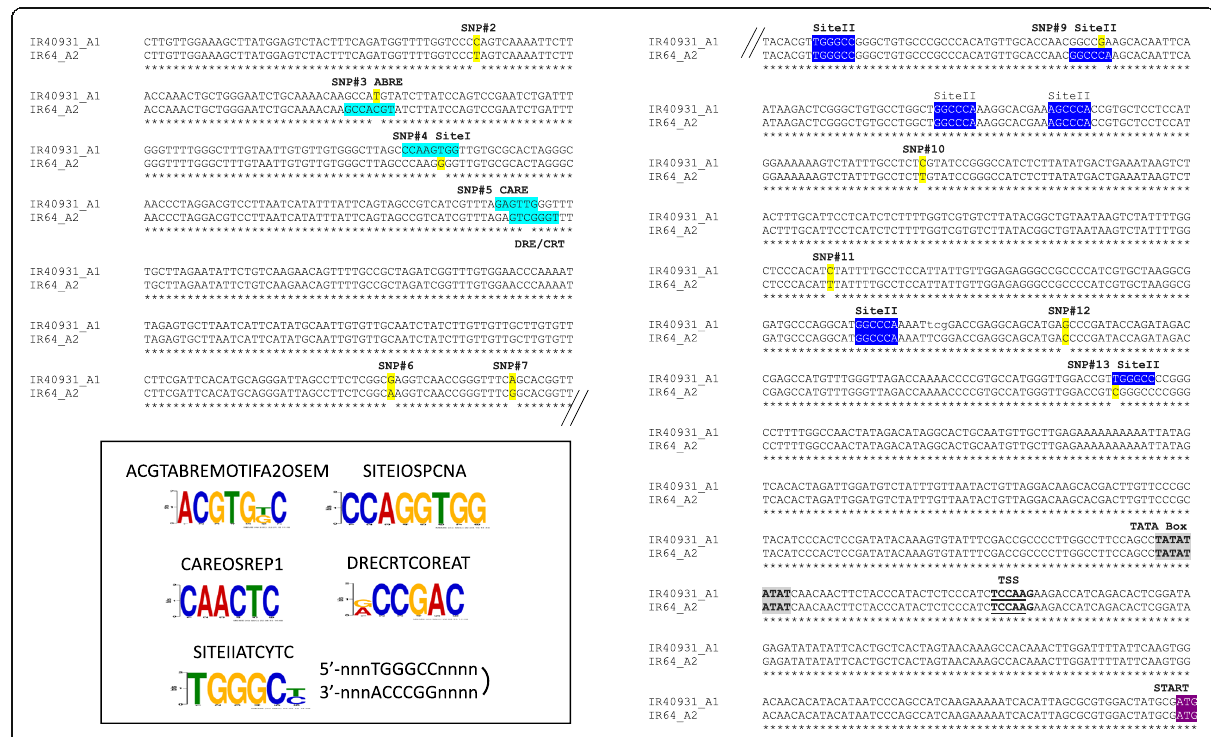
Fig. 5 Comparison between the SUB1A-1 and SUB1A-2 upstream region. The SUB1A-1 and SUB1A-2 upstream regions were aligned and analysed to identify the promoter region and allele-specific putative cis -elements constituted by the thirteen single nucleotide polymorphisms (SNPs). Annotation of the putative cis -elements is indicated in the figure and explained in detail in the text. Other relevant promoter elements are additionally indicated. TSS, transcription start site. The complete alignment is provided in Additional file 1: Figure